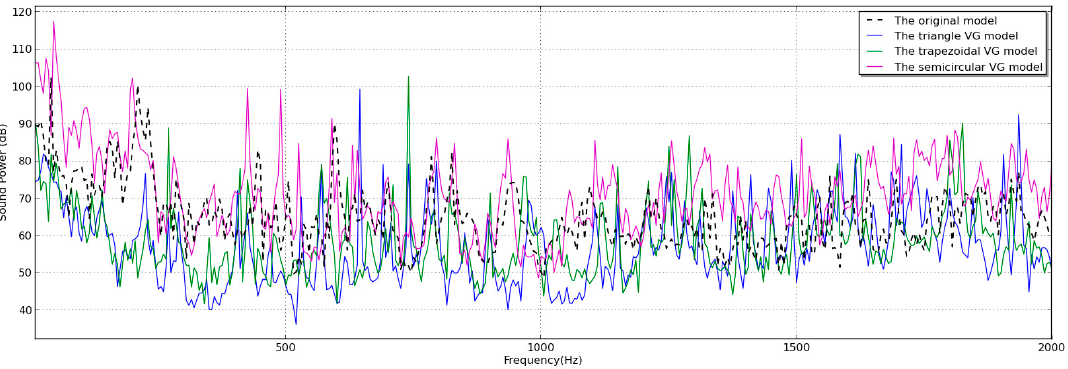
Figure 7. The mechanical vortex generators (VGs) on the model: ( a ) triangular; ( b ) trapezoidal; ( c ) semi-circular.